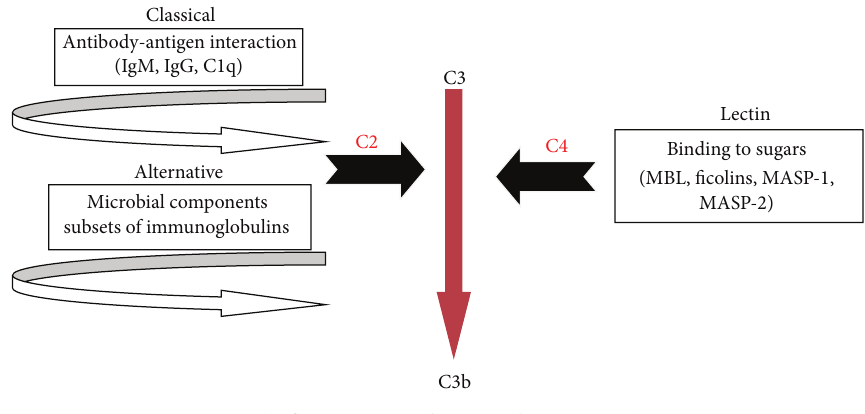
Figure 1: Complement activation